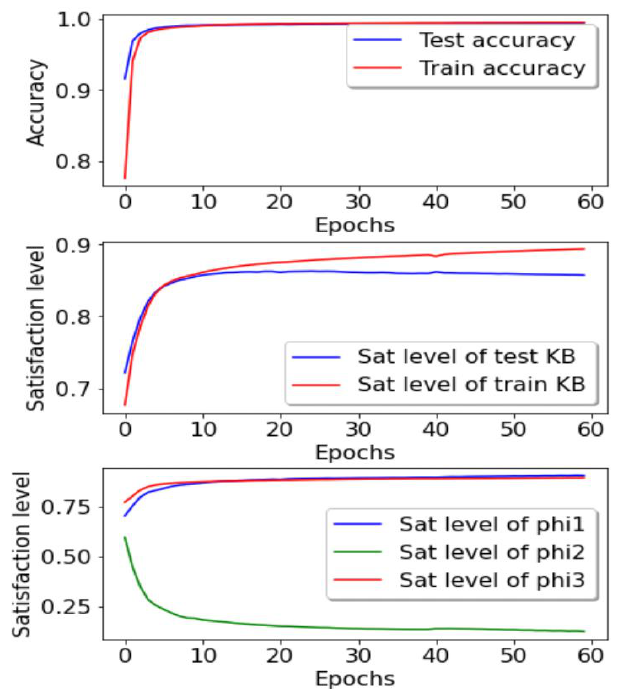
Figure 4. Comparison of accuracy, satisfiability and querying of